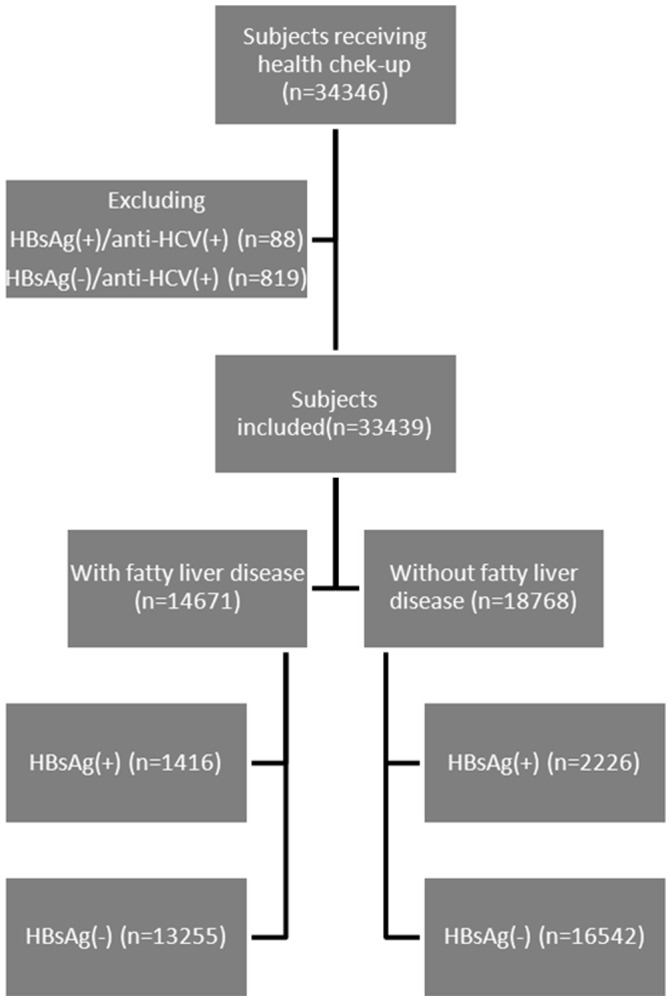
The flow of subjects in the study.